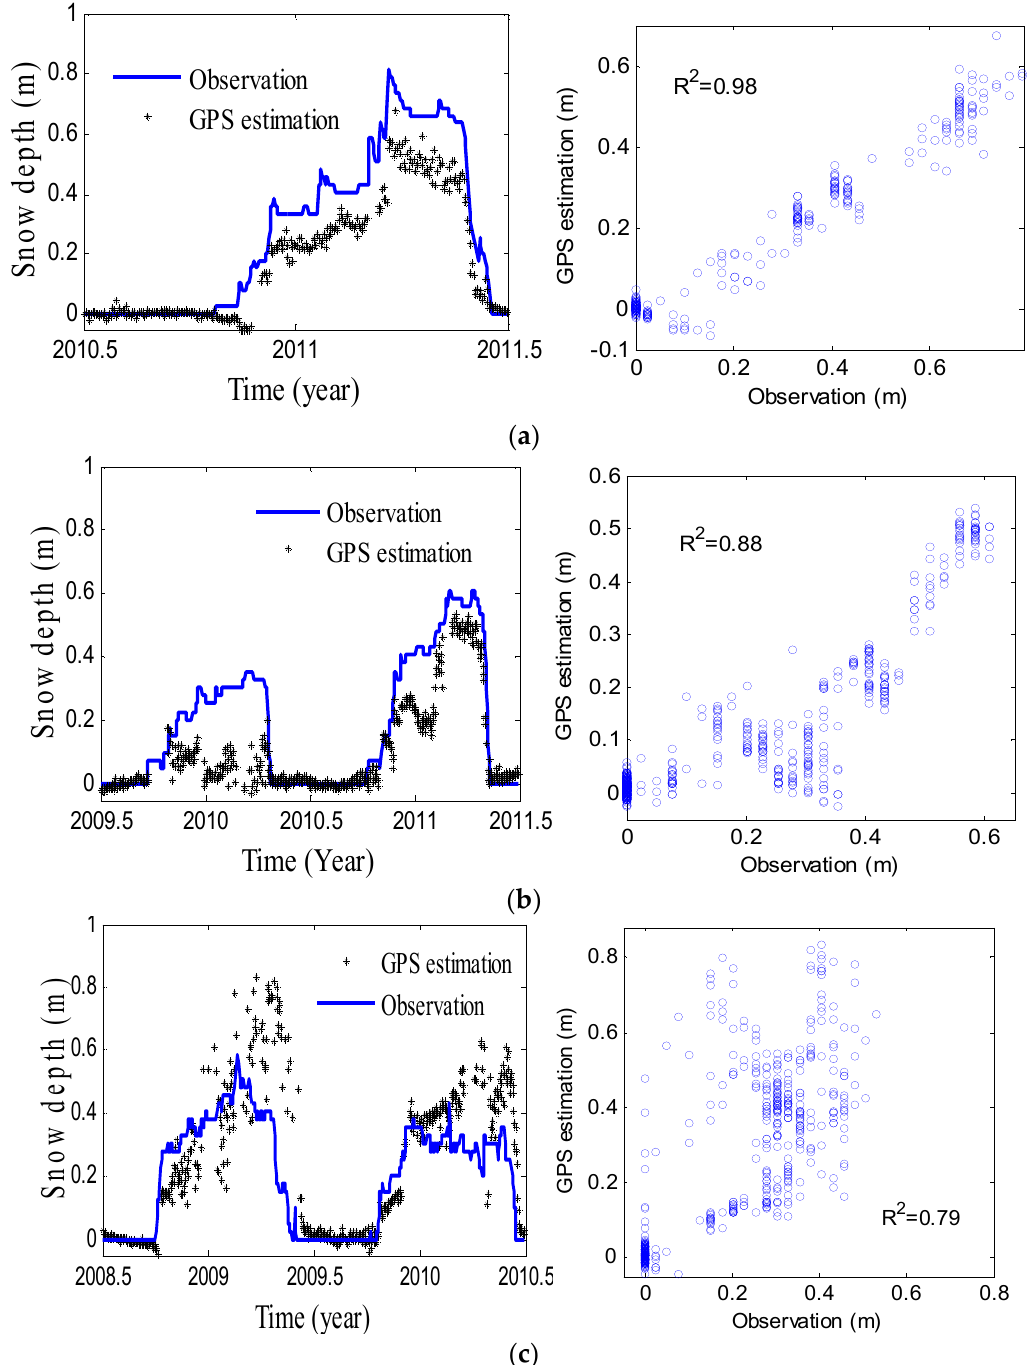
Figure 9. Comparison of GPS and in situ snow depth at AB33, AB39 and SG27. ( a ) AB33; ( b ) AB39; ( c ) SG27.